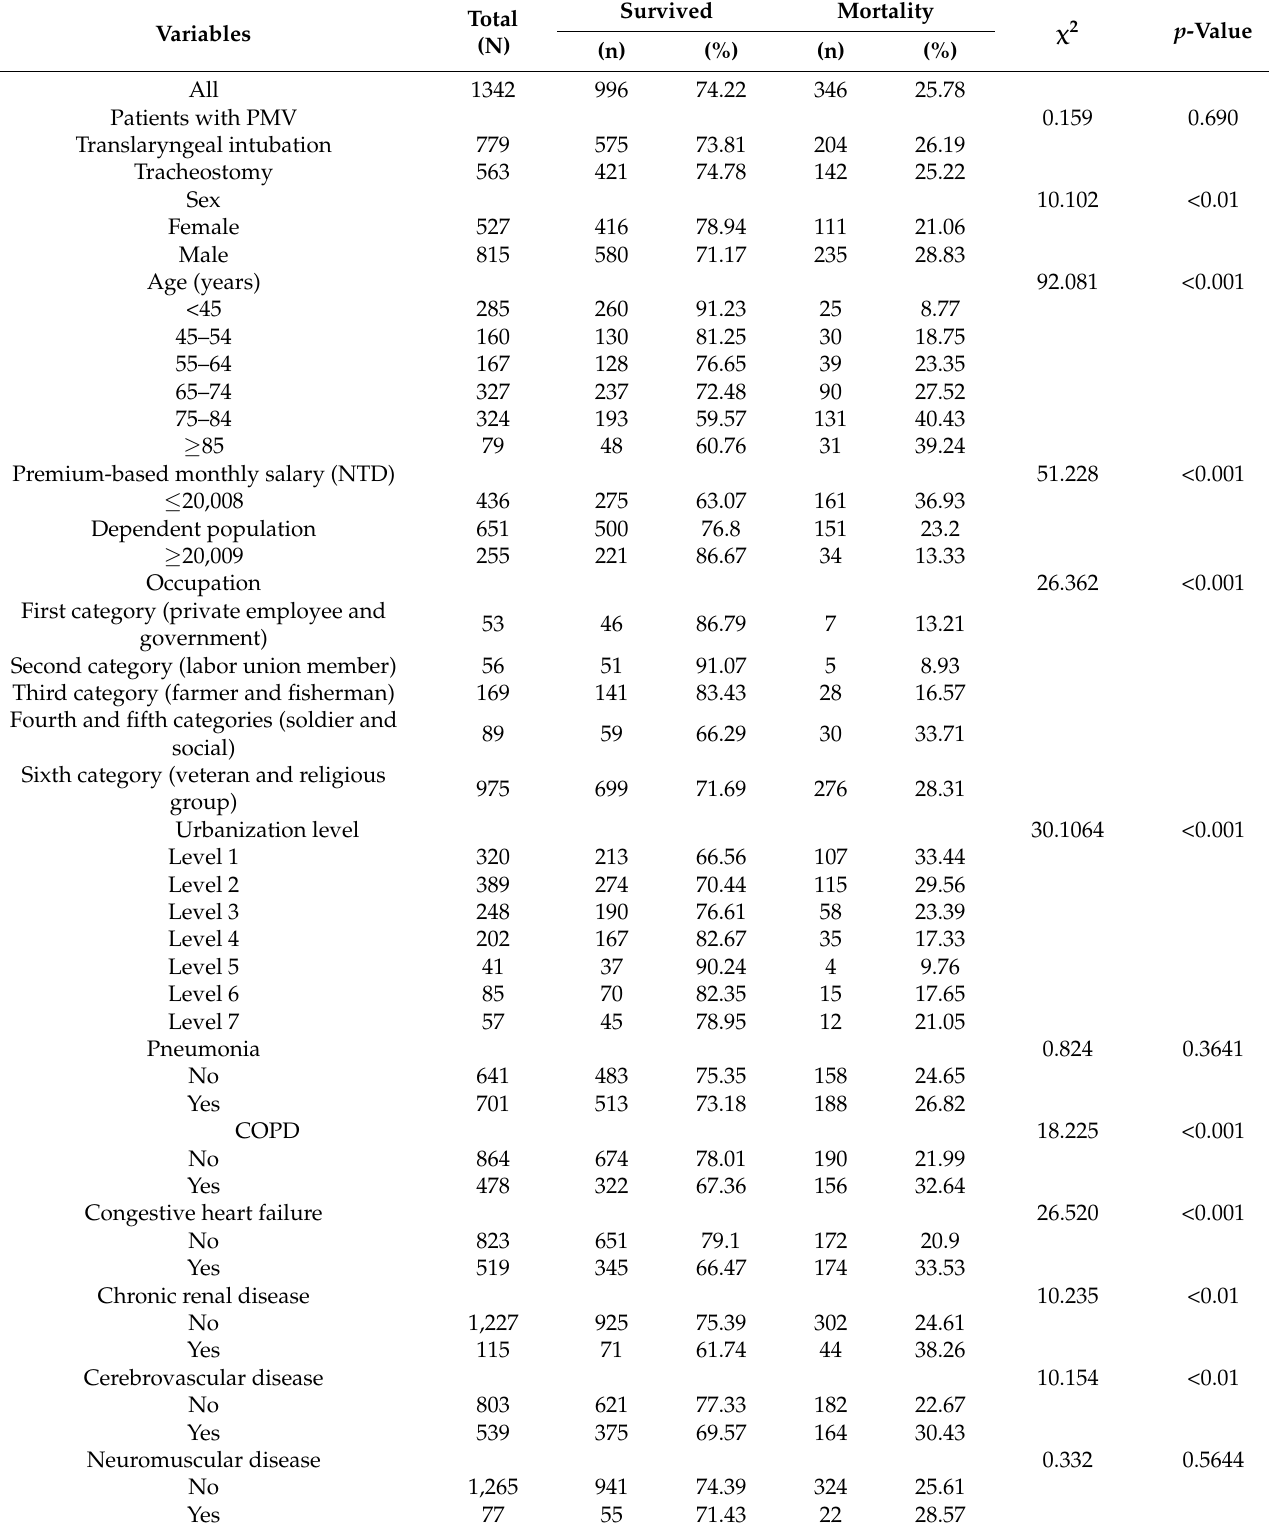
Table 3. Univariate analysis of patients with PMV